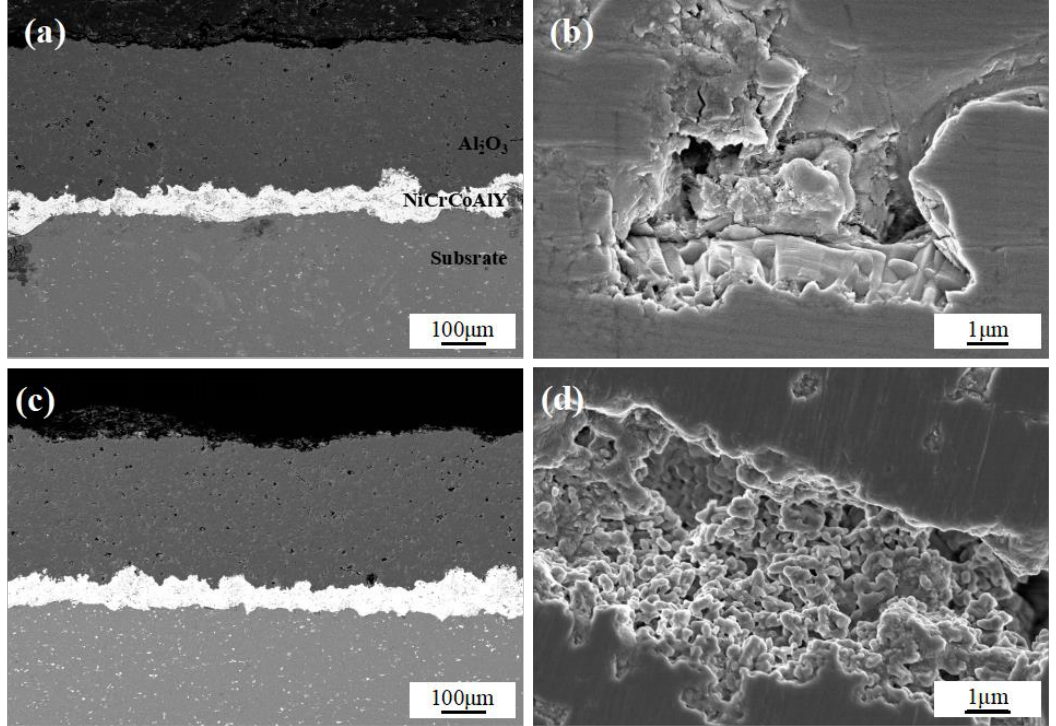
Figure 7. Cross-sectional morphology of ( a , b ) micro Al 2 O 3 coating and ( c , d ) nano Al 2 O 3 coating.